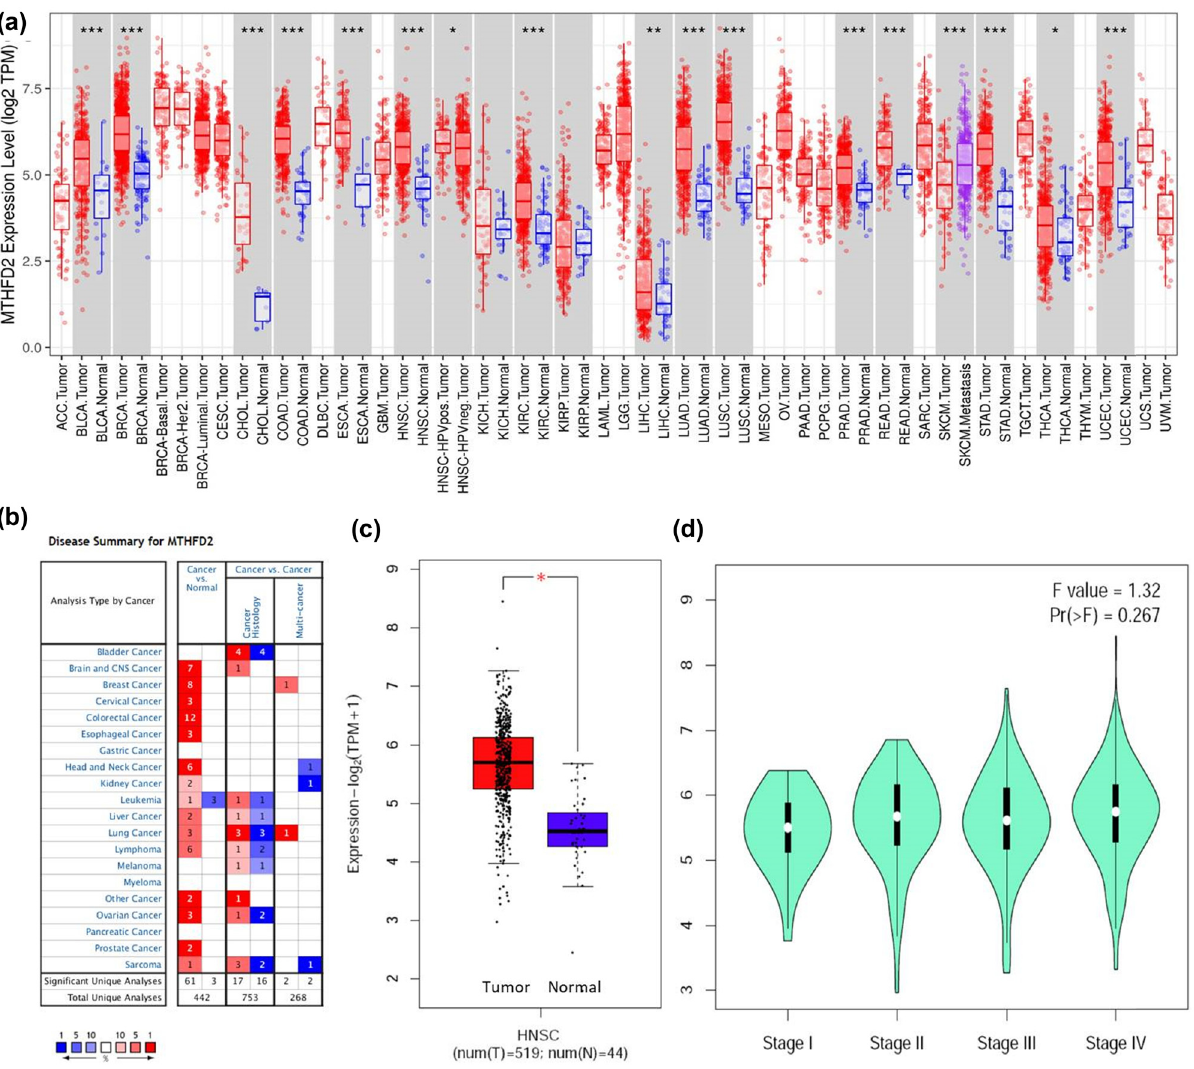
Figure 1: Expression analysis of MTHFD2 gene in HNSCC ( a ) relative expression level of MTHFD2 in various human solid tumors; ( b ) MTHFD2 expression pattern in major malignant carcinoma in oncomine database; ( c ) box plot of MTHFD2 expression in HNSCC; ( d ) MTHFD2 expression between di ff erent stages of